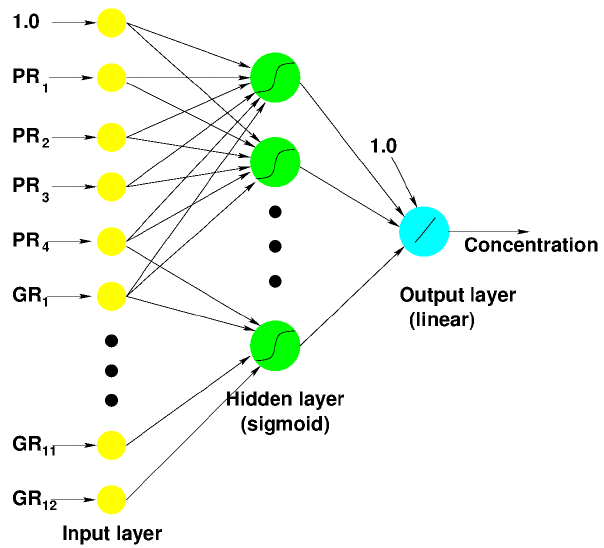
Fig. 2. A schematic diagram of the MLP architecture used, there are 17 input layer units (including the Figure 2. A schematic diagram of the MLP architecture used; there constant term 1.0, 20 hidden layer sigmoid units, and one linear output layer unit. For clarity not all the are 17 input layer units (including the constant term 1.0, 20 hidden- connection have been drawn in the figure. layer sigmoid units and one linear output layer unit). For clarity not all the connections have been drawn in the